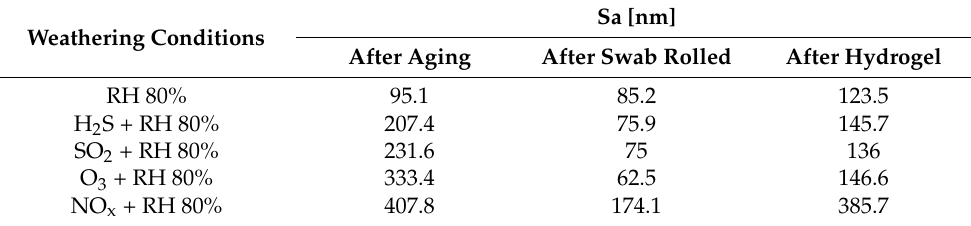
Table 4. AFM roughness values (Sa) obtained after gas aging and after cleaning